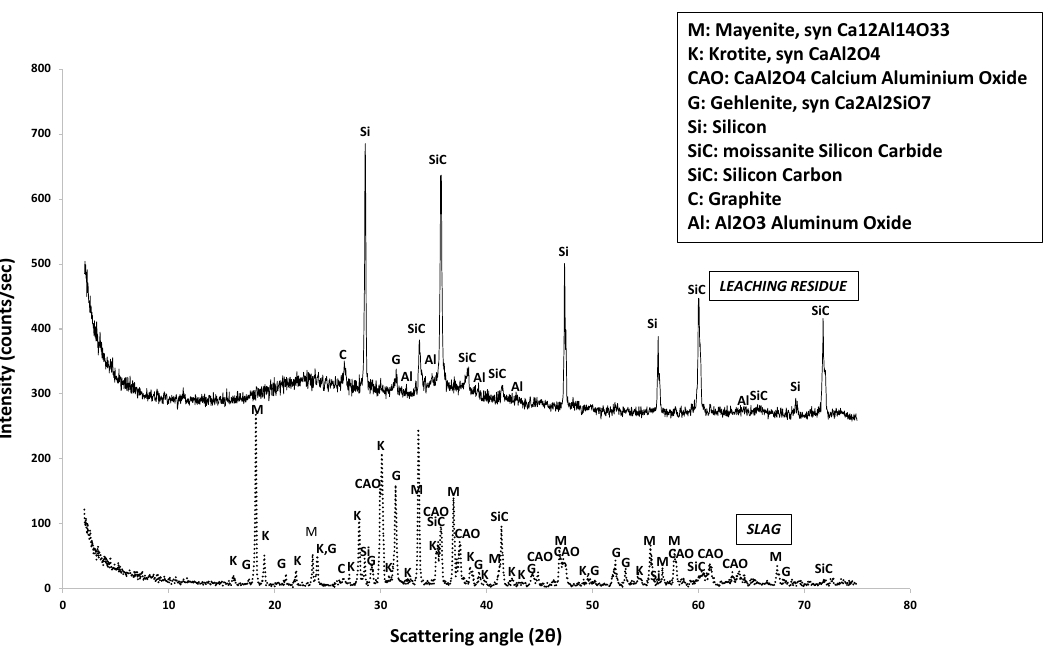
Figure 2. XRD pattern of raw Ca-Al slag material and XRD pattern of the residue after the acid leaching.